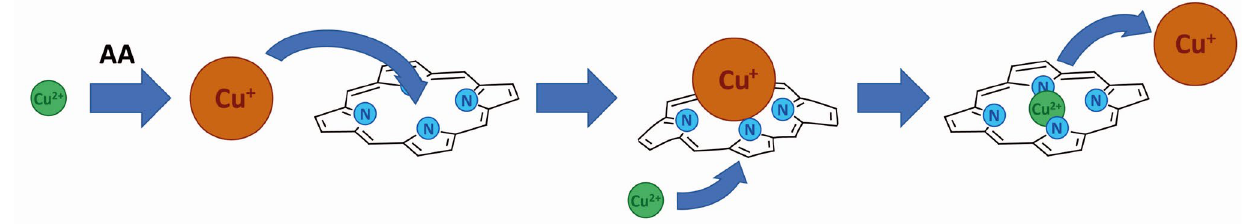
Figure 4. Overview scheme of synthesis of Cu(II)–poprhyrin complex involving formation of complex with large ions generated by reduction of Cu 2+ ion to Cu + ion with ascorbic acid (AA).